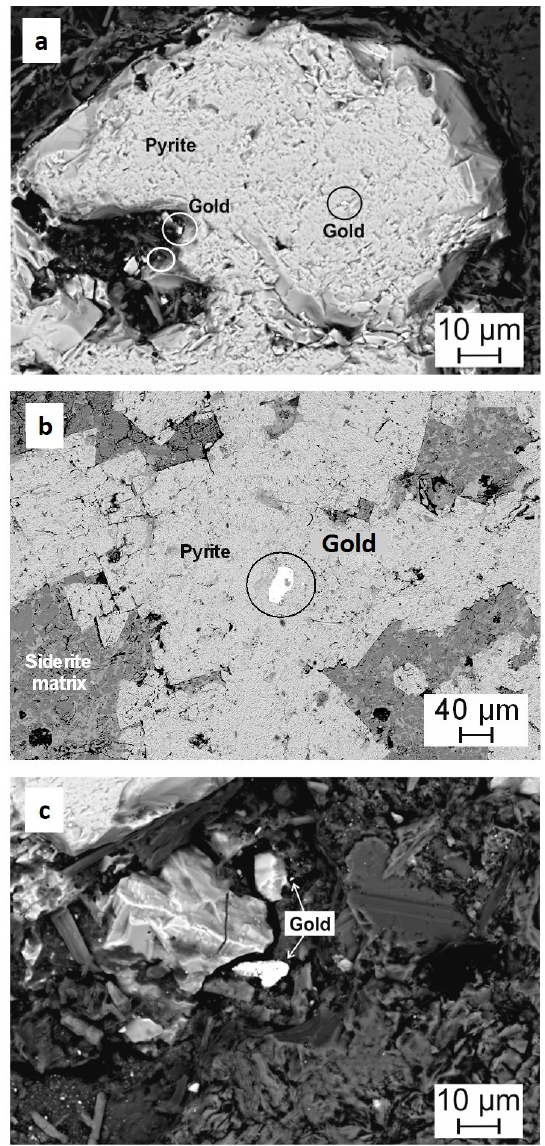
Figure 5. Mineralogy of Castlecomer coal samples. ( a ) Pyrite within the coal matrix (closely associated with a siderite nodule), containing discrete gold grains. ( b ) Siderite nodule with pyrite filling the septarian cracks, and a large gold grain present. ( c ) Gold grains at the edge of pyrite in coal.